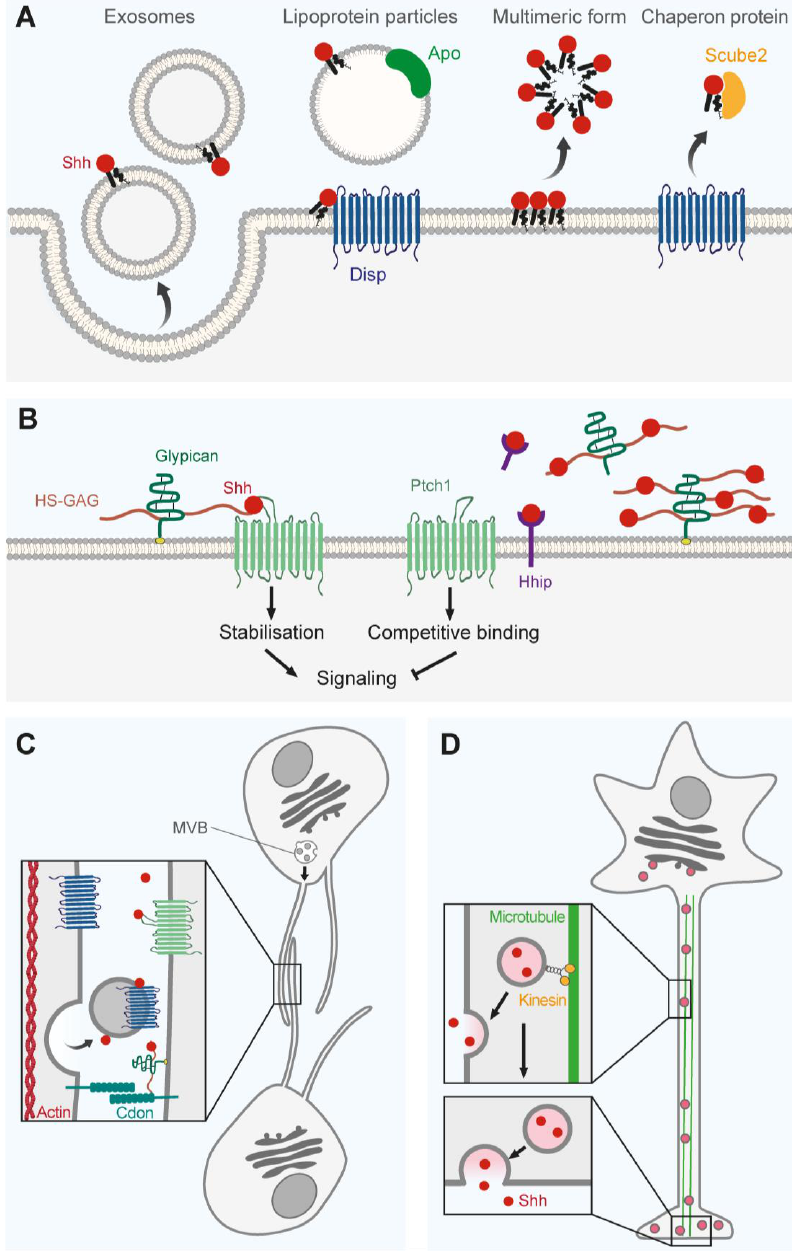
Figure 3. Transport mechanisms and cell-surface regulation of Hedgehog signaling. ( A ) Shh can be secreted out of cells by several mechanisms such as exosomes. Shh can also be transported by lipoprotein particles. Finally, the Shh peptide itself can be secreted directly by Dispatched at the membrane and subsequently form multimeric complexes or complexes with the chaperone protein Scube2. ( B ) At the cell surface glypicans can bind Shh through their GAG chains to stabilize ligand- receptor interaction and promote signaling. Conversely, both membrane-anchored and cleaved glypican and Hhip can sequestrate Shh preventing Hedgehog pathway activation. ( C ) Shh can also be delivered through direct cell–cell interaction via cytonemes. Shh is transported along cytonemes by exosomes originating from MVB. Dispatched and Ptch1 are localized at cytoneme sites to enable Shh release and signaling, respectively. Both Cdon and glypicans are required for cytoneme stabilization and Shh reception. ( D ) In neurons, Shh is transported along the axon and can be released at several sites: Shh can be secreted down the axon or directly at the